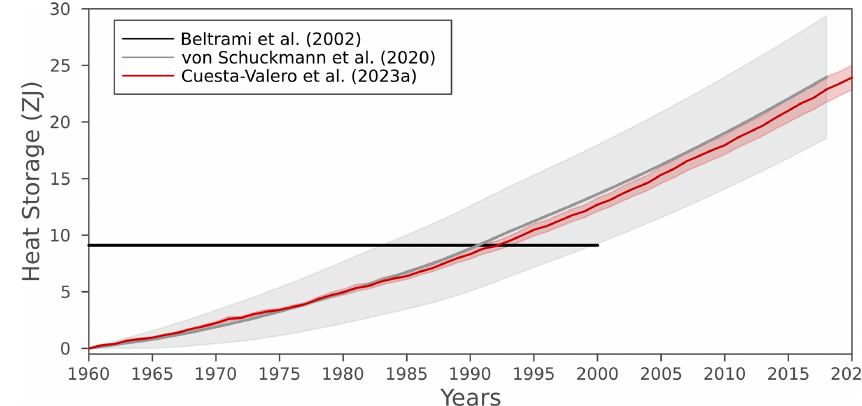
Figure 6. Continental heat storage from Beltrami et al. (2002) (black), von Schuckmann et al. (2020) (gray), and Cuesta-Valero et al. (2023a) (red). Gray and red shadows show the uncertainty range of the heat storage from von Schuckmann et al. (2020) and Cuesta-Valero et al. (2023a),